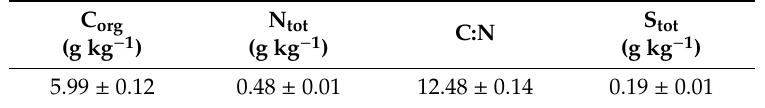
Table 2. Initial chemical properties of soil uncontaminated with petrol.